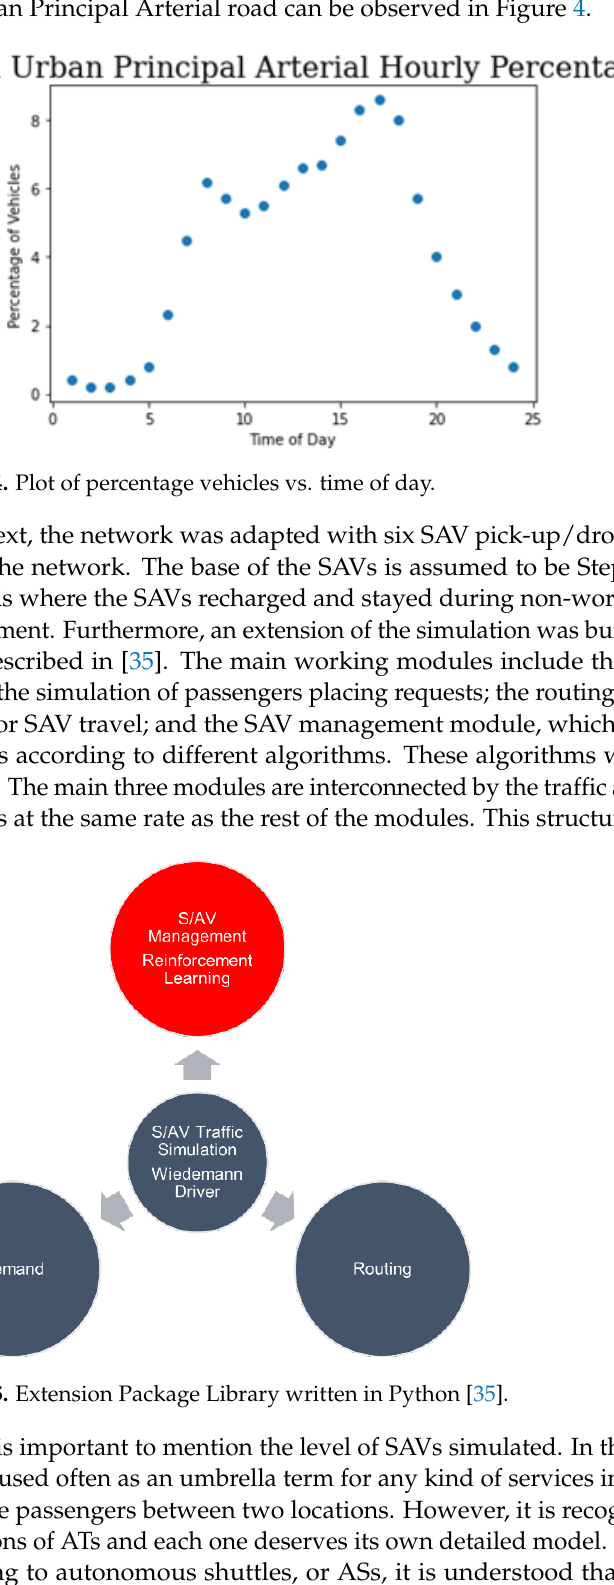
Figure 3. Simulated Area of Deployment.